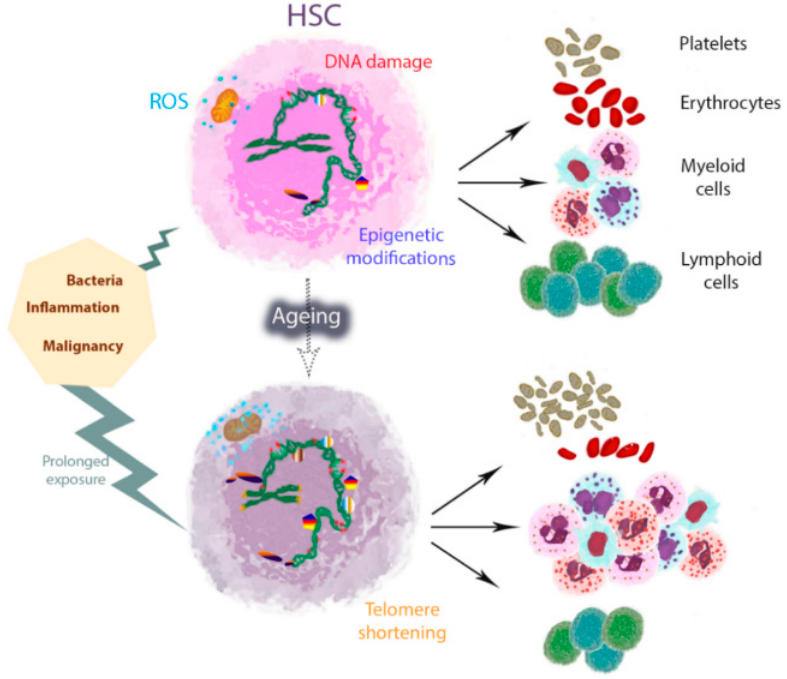
Figure 1. Model of haematopoietic stem cell (HSC) myeloid and platelet skewing with ageing in mice. One of the typical characteristics of HSC ageing is myeloid and platelet HSC skewing, which is accompanied by profound changes in the epigenetic landscape and gene expression profiles. HSC activation in response to external stimuli such as infections and inflammation elicits HSC differentiation and myeloid skewing, aimed at mediating rapid myeloid cell recovery at the expense of their self-renewal capacity. HSCs shift from quiescence to more cycling states, with increased reactive oxygen species (ROS) levels and DNA damage. Prolonged exposure during life may potentially cause the accumulation and aggravation of changes, including telomere shortening, ultimately reducing HSC survival and differentiation potential. The course of lifetime is represented by a dotted